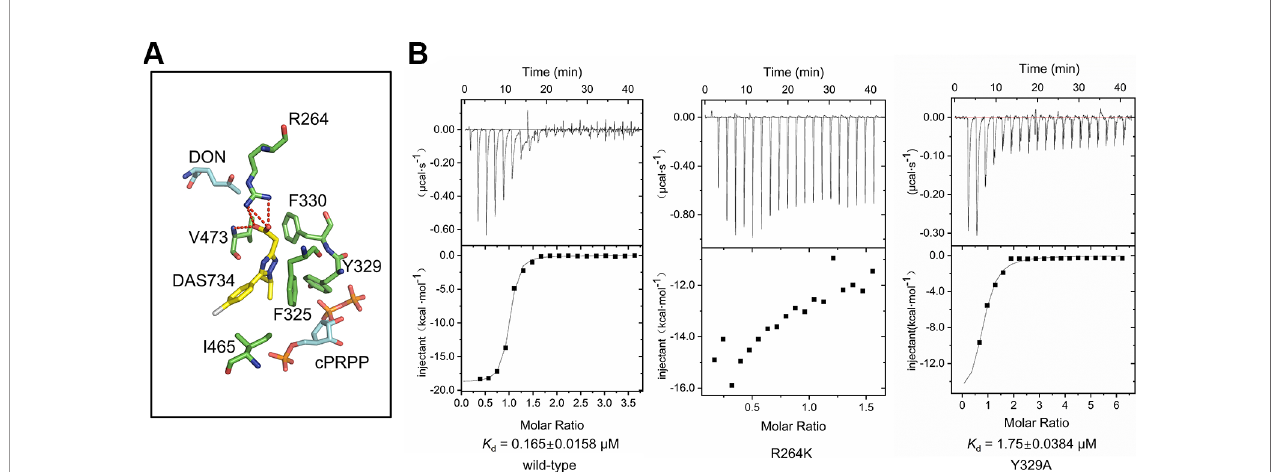
FIGURE 4 | The binding site of DAS734. (A) Structural superimposition of AtGPRAT2 with docked DAS734 and EcGPRAT in the active [Protein Data Bank (PDB): 1ECC] conformation. The AtGPRAT2 residues involved in DAS734 binding are shown as sticks. The carbocyclic phosphoribosyl pyrophosphate (cPRPP) and 6- diazo-5-oxo-L- nor -leucine (DON) molecules in EcGPRAT are colored as in Figure 3B . Electrostatic interactions and hydrogen bonds are shown as red dashed lines. (B) Interaction of AtGPRAT2 mutants and DAS734 as detected by isothermal titration calorimetry (ITC). The ITC curves are shown. The calculated K d mean ± SE values are indicated. The top plots represent time, and the bottom plots represent molar ratio. These experiments were performed twice with equivalent results.